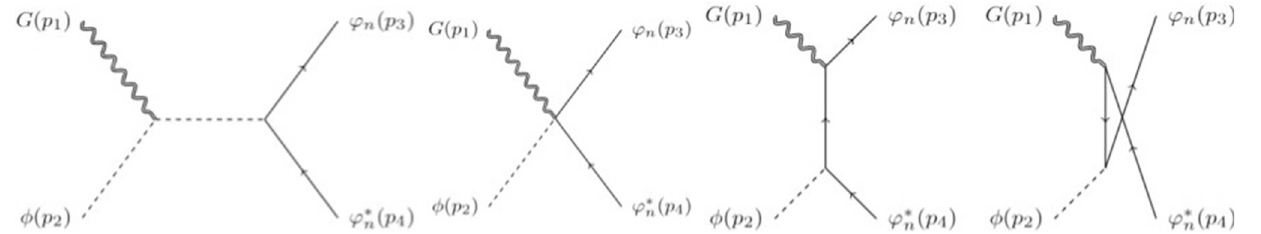
Fig. 4 Feynman diagrams for the mixed pair production from a graviton and a